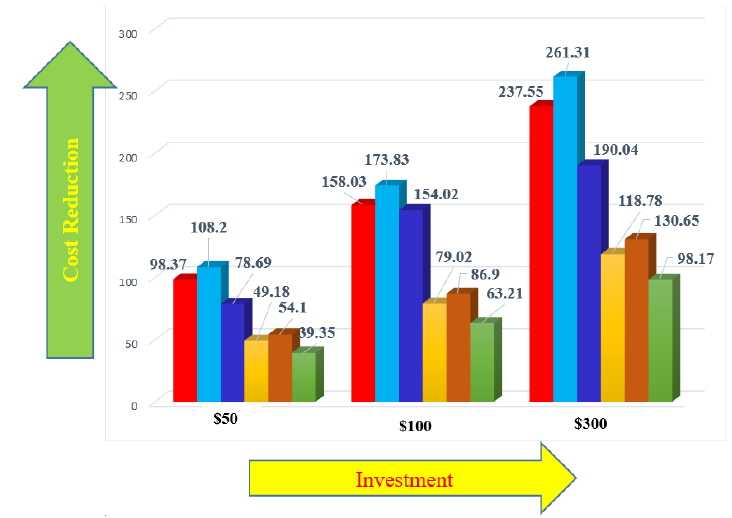
Figure 3. Graphical representation of investment versus setup cost reduction.